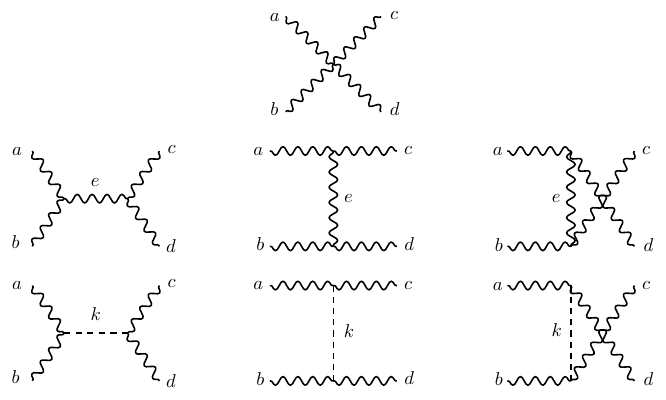
Figure 1 . Amplitudes for the scattering A a A b ! A c A d